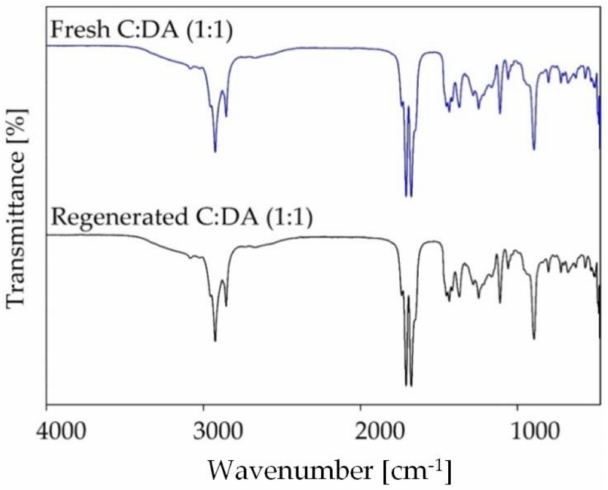
Figure 16. FT-IR spectra of the DES-based absorbent after the regeneration